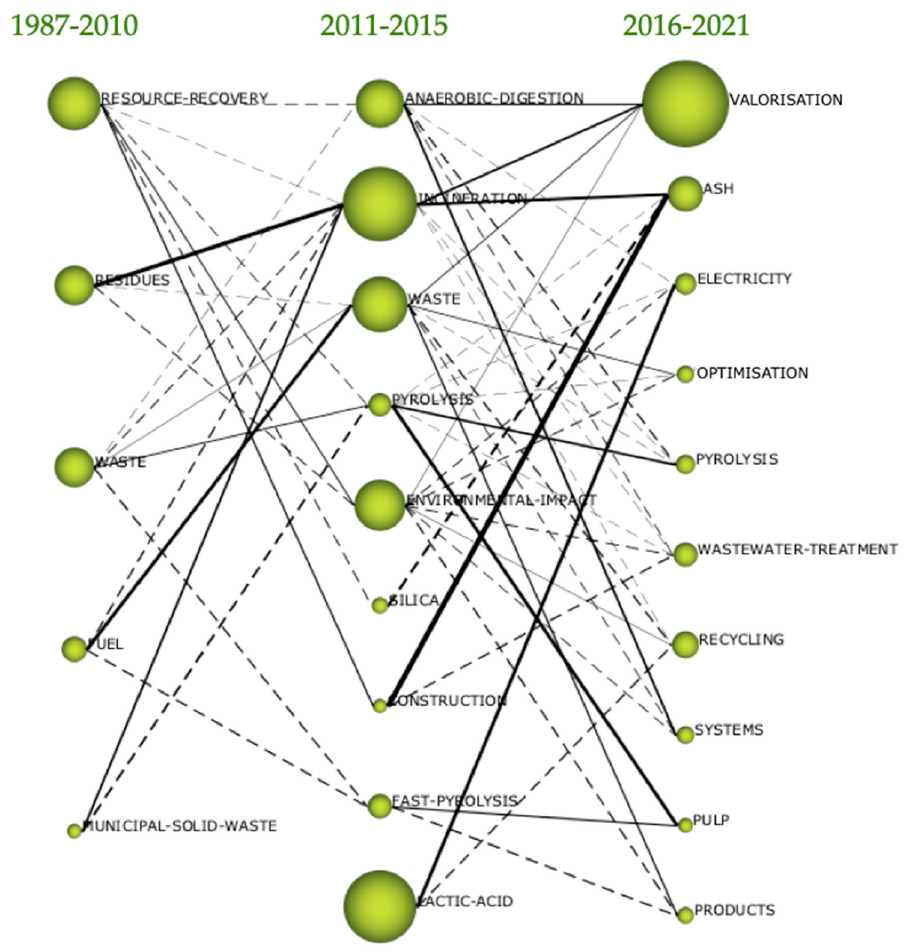
Figure 8. Thematic evolution map.